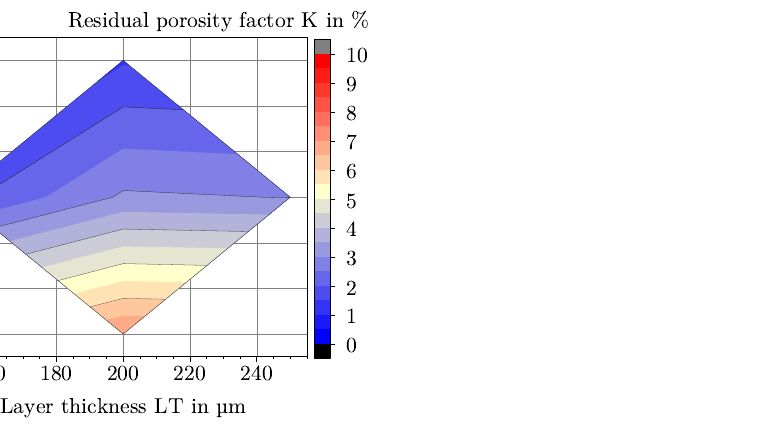
Figure 11. Dependence between the residual porosity factor K at optDF and LT and DAR. Between the five measured points from Table 4, the residual porosity factor is approximated.